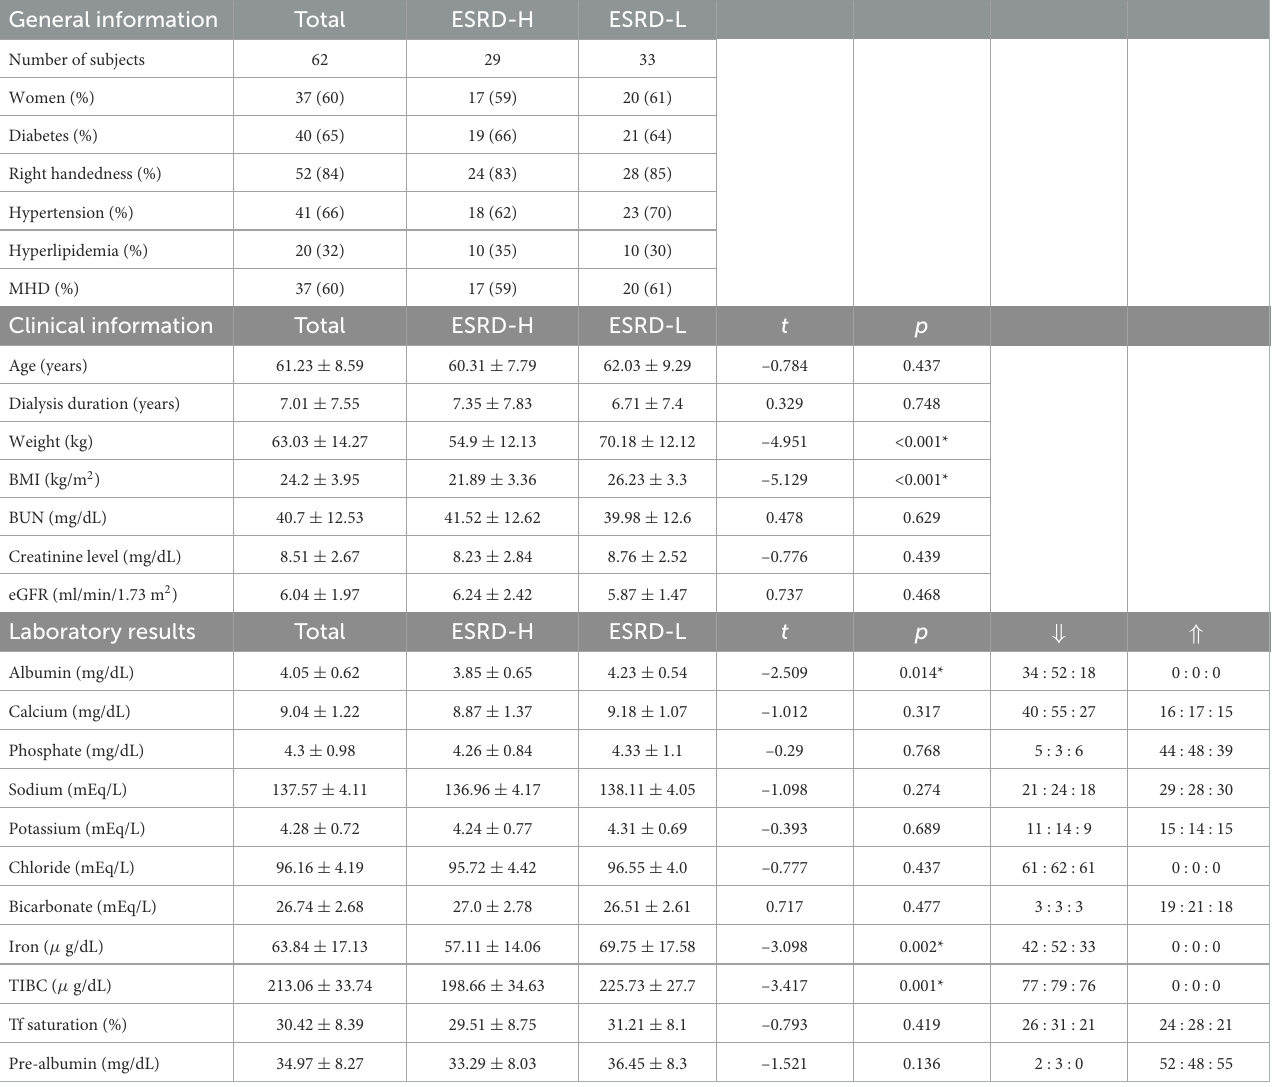
(Table 1). The seventh, second, and sixth components, which indicate muscle wasting, dietary intake, and loss of subcutaneous fat, were considerably different. The eighth, fourth, and third components, which indicate BMI, daily functional capacity, and gastrointestinal symptoms, were moderately different. Finally, the ninth and first components of MIS, which indicate the serum albumin level and dry weight alterations after dialysis, were almost not significantly